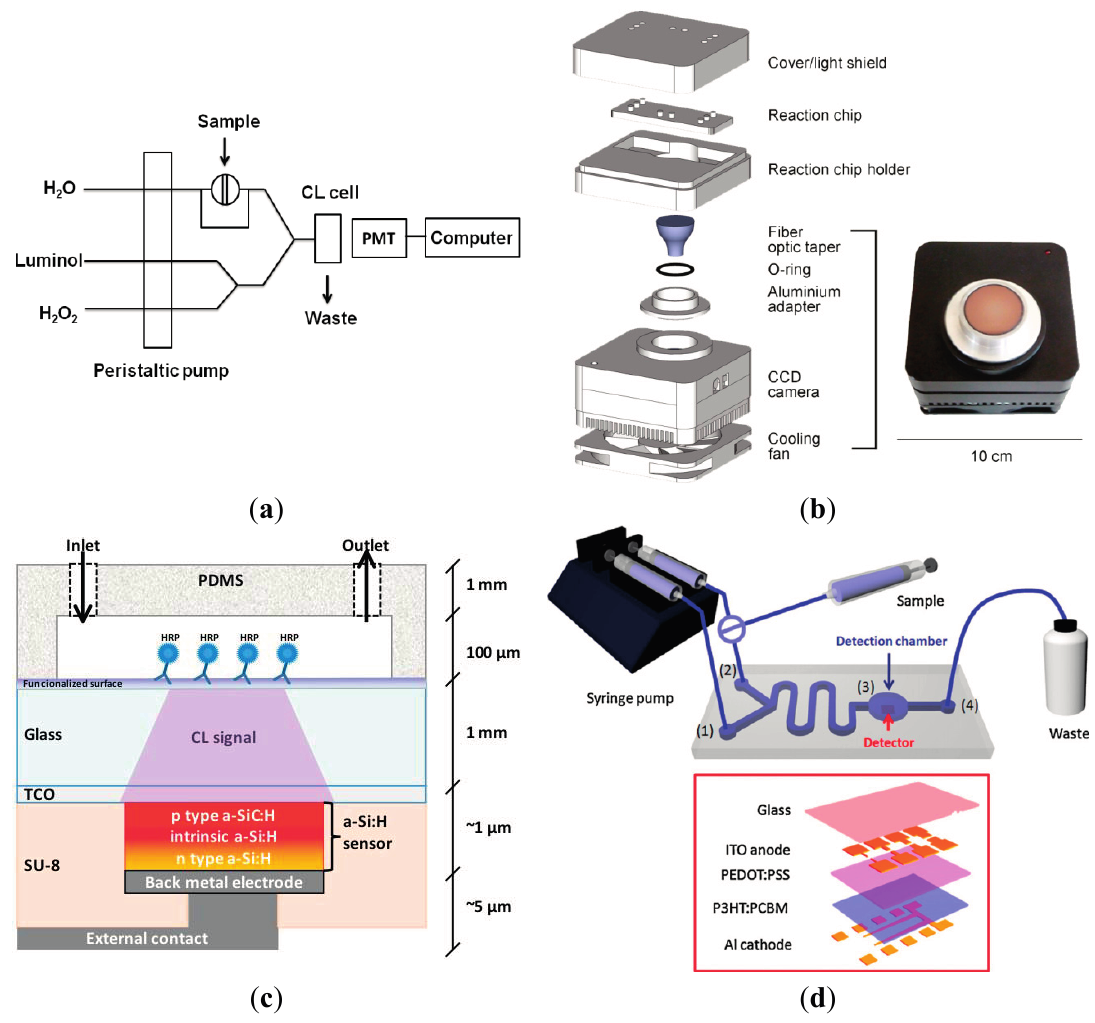
Figure 2. Methods of chemiluminescence (CL) detection in microfluidic systems. ( a ) Flow injection system for CL analysis using PMT technology [53]; ( b ) Microfluidics-based device incorporating a thermoelectrically cooled CCD camera. Reprinted with permission from (with permission from [73]); ( c ) Integrated opto-microfluidic sensor with